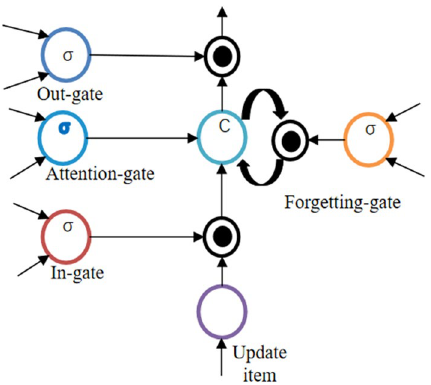
Figure 4. The storage unit regularly balances the content, and the replacement is controlled by four gates. Function based weight unit generation in gating phase. In addition, the hidden layer state and image features of the last node extracted by CNN are input to the unit, and the stimulation function is analyzed by machine vision.